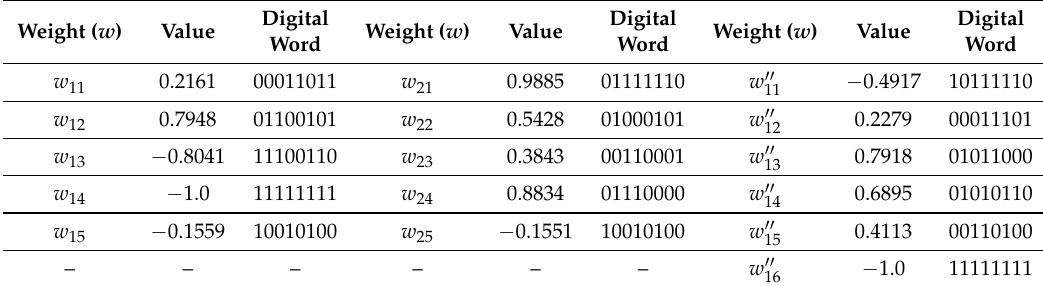
Table 5. Digital weights obtained after the learning